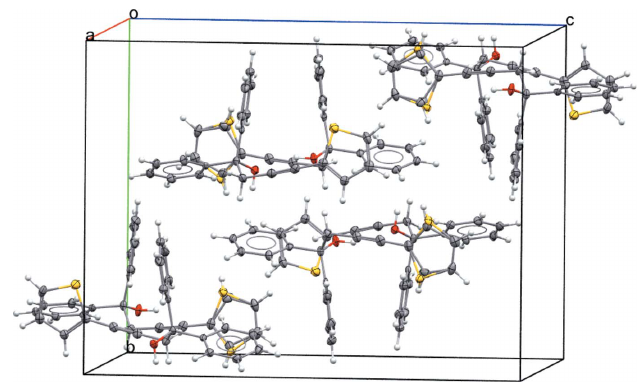
Figure 2 Crystal packing of the title compound viewed approximately down the a axis.